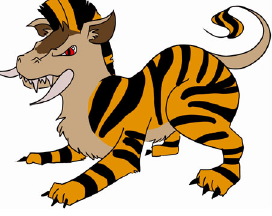
FIG. 3. The boar tiger, which is used as a cultural artifact in